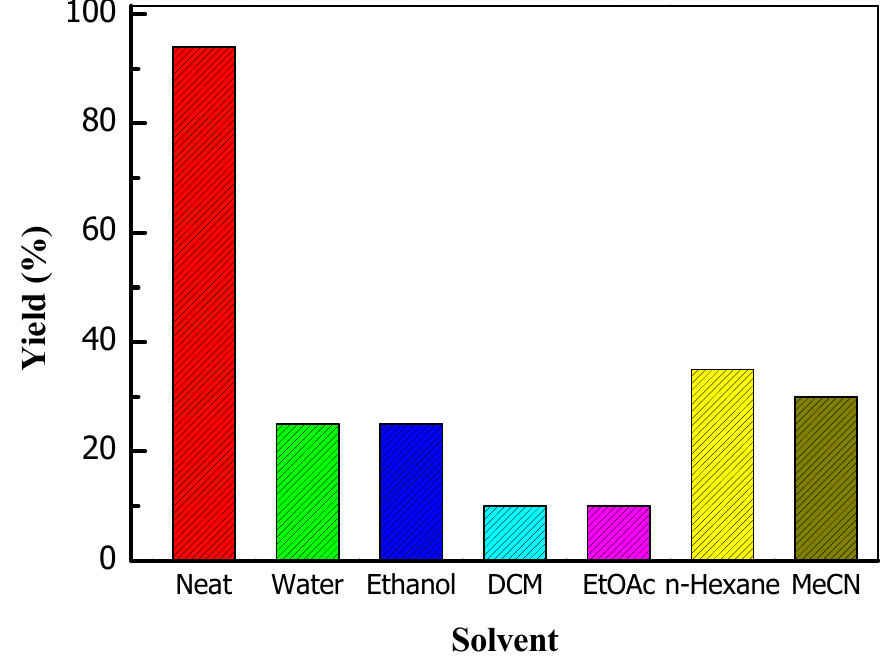
Figure 7. Influence of the solvent in the catalytic synthesis of 2-amino-3-cyanopyridine 5a . After determining the optimal conditions for the synthesis of 2-amino-3-cyanopyridine 5a, the reactions of different aromatic aldehydes containing substituents in the aromatic ring, such as Me, OMe, Cl, and NO 2 , with malononitrile 2 , acetophenone derivatives, or cyclohexanone 3 and ammonium acetate 4 were carried out under identical reaction conditions. The thirteen desired 2-amino-3-cyanopyridine derivatives 5(a–m) were obtained with good to excellent yields (84–94%), as shown in Table 2. The nature of aromatic ring substituents had no noticeable effect on the yields of synthesized 2-amino-3-cyanopyridines 5. All reactions with aromatic aldehydes proceed without the formation of